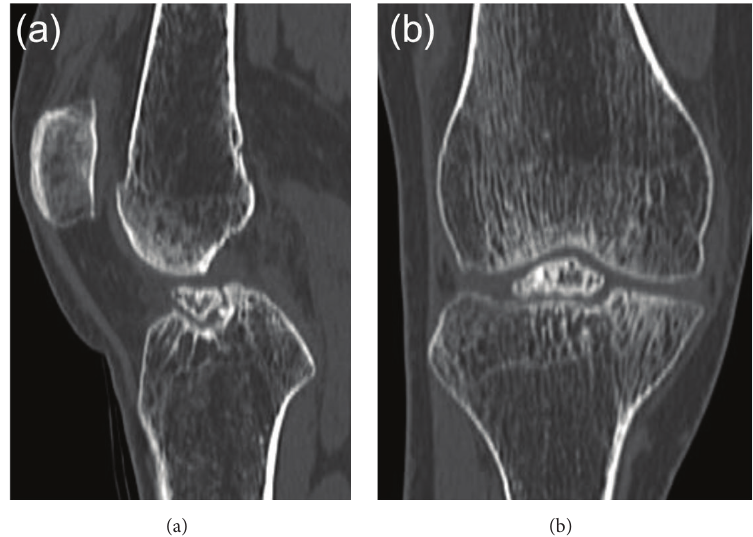
Figure 2: Preoperative computed tomography of our patient. (a) Sagittal and (b) coronal views, showing the avulsed fragment at the anterior tibial eminence of the right knee impinging on the femoral intercondylar